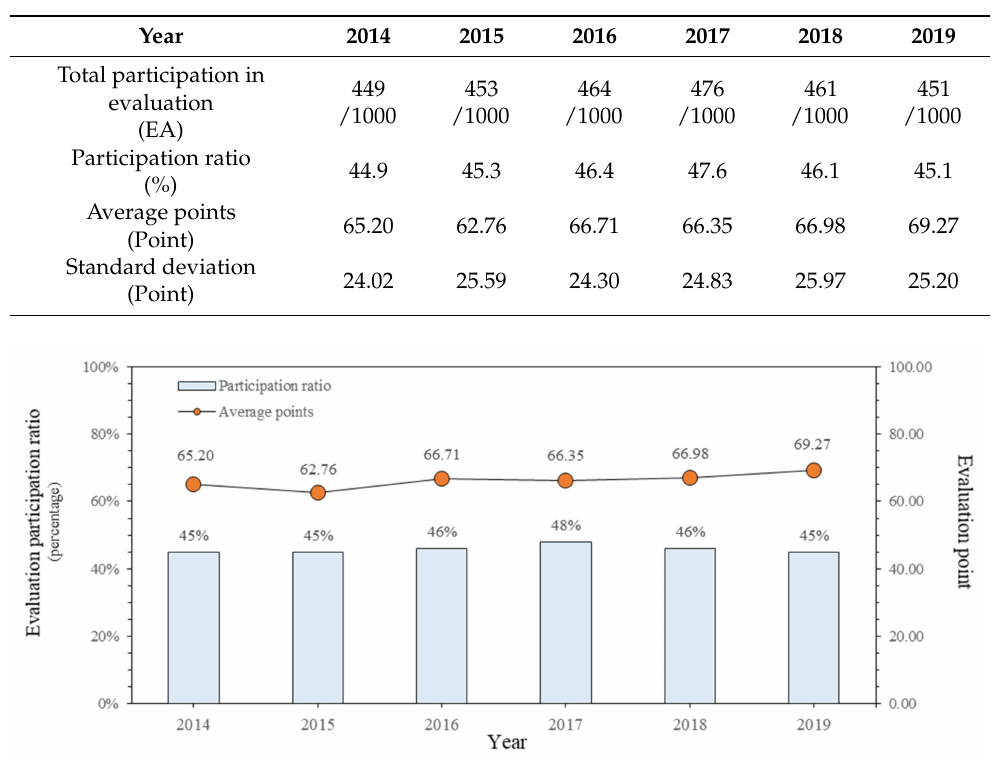
Table 4. Average points of evaluation performance by year.